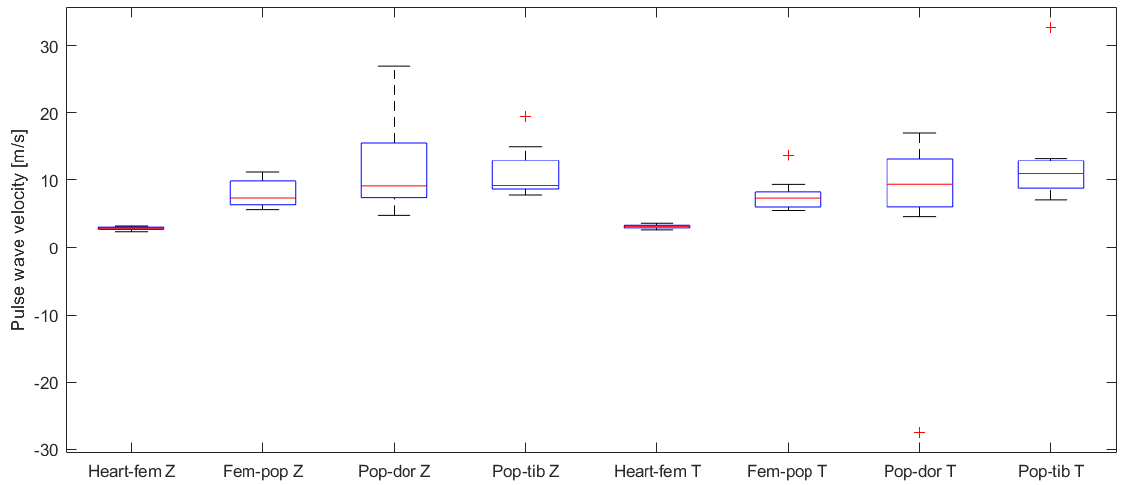
Figure 5: The distribution is displayed in boxplots, which are made of the interquartile ranges of the pulse arrival times (PAT) in milliseconds (ms) estimated by the bioimpedance (Z) and tonometer (T) from the nine healthy participants for the a. femoralis, a. popliteal, a. tibialis posterior and a. dorsalis pedis. First the interquartile ranges of the PAT for every artery from all the participants were determined. Subsequently a distribution of these interquartile ranges was made. The average interquartile range for bioimpedance (Z) is 11.48 ms and for tonometer (T) is 9.44 ms in all arteries.